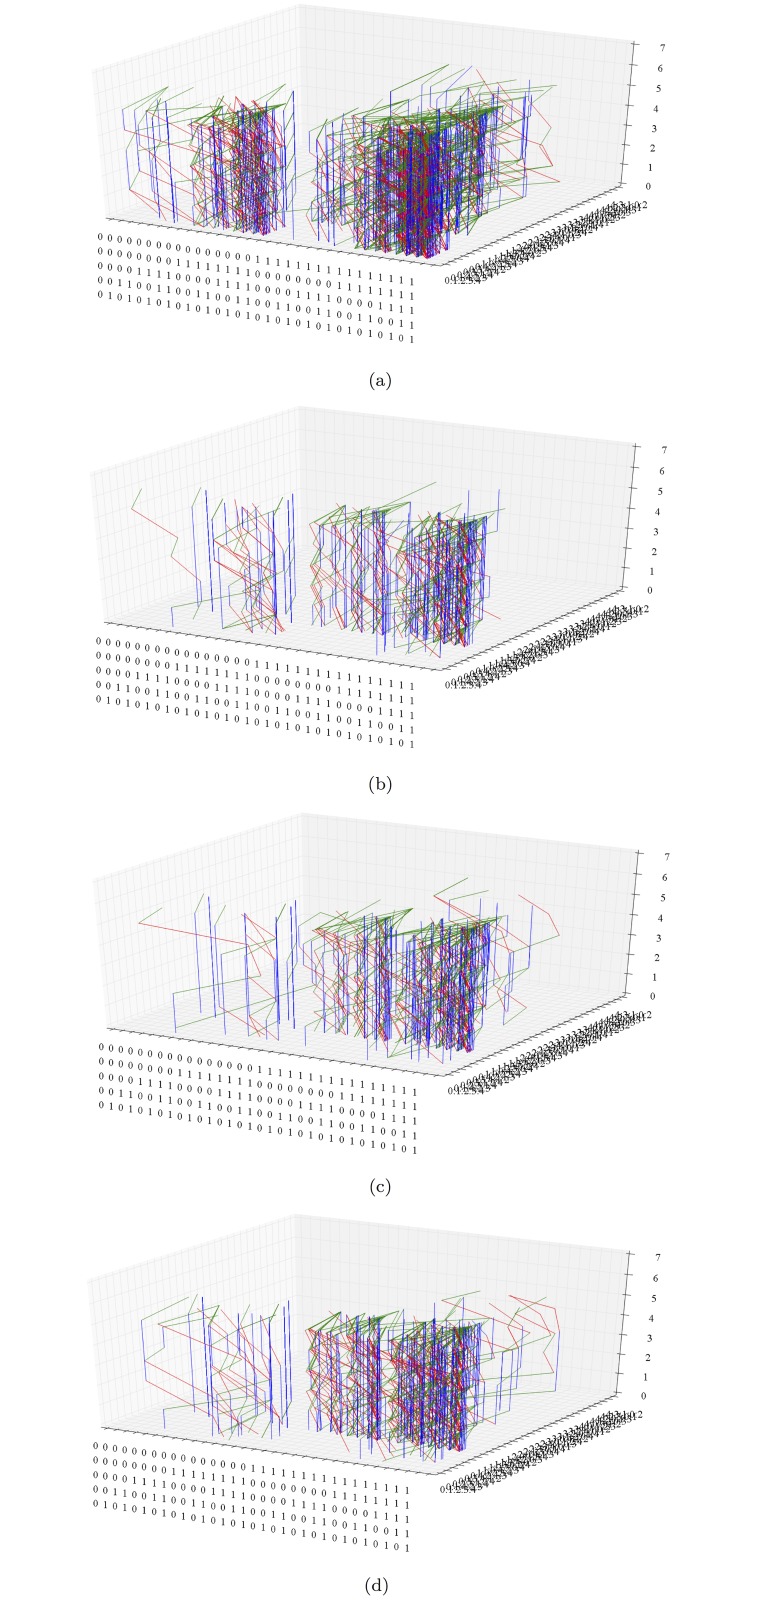
Column structures over clusters of (a) SA Rich, (b) SA Poor, (c) MOZ Rich, and (d) MOZ Poor household orbits in S
5.